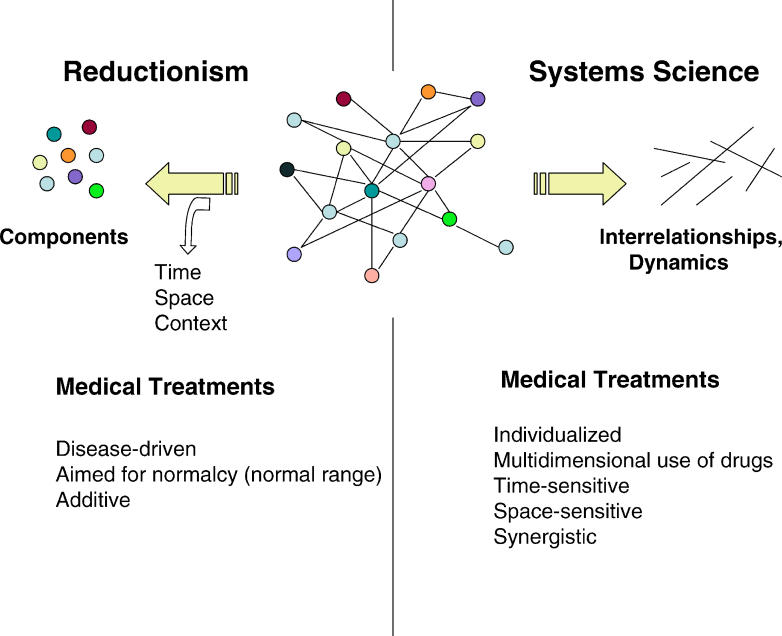
Medical Treatments: Reductionism versus Systems ScienceTreatment differences stem from divergent problem-solving tactics. Reductionism focuses on components and, in the process, can lose information about time, space, and context. Systems science focuses on the interactions and dynamics and spends less time studying the individual components.